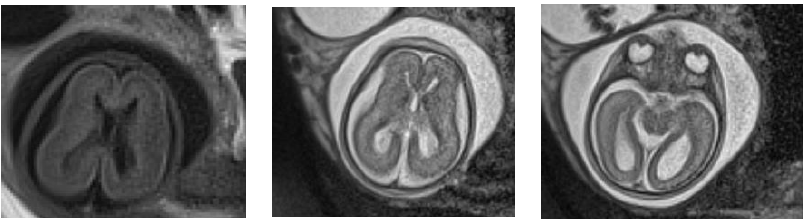
Figure 1. MRI at 24 weeks of gestation: no Sylvian fissure are seen; ventricular dilatation; the parieto-occipital and Sylvian fissures appear flat and the subarachnoid space is increased. The infant was fed with a special milk formula for premature infants since birth; however, the daily intake was poor (only 300 mL). Consequently, his weight gain was below normal (600 g in six weeks).